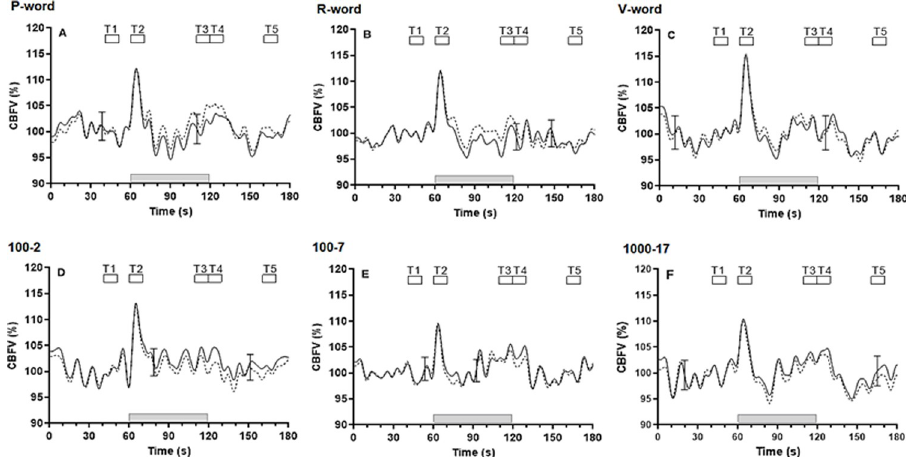
Fig 2. Average population responses (n = 16) in the right (continuous line) and left (dashed line) hemispheres for the complexity of NW (A, B, C) and SS (D, E, F) paradigms of CBFV, respectively. Error bar represents the largest ± SD at the point of occurrence. Changes are shown before, during (grey bar) and after 60s of P-word (A), R-word (B), V-word (C), 100–2 (D), 100–7 (E) and 1000–17 (F). Responses were synchronized by the beginning of stimulation, set at 60s. For statistical analyses, shorter segments (T1-T5) were averaged from 40-50s (T1), 60-70s (T2), 110-120s (T3), 120- 130s (T4) and 160-170s (T5), respectively.